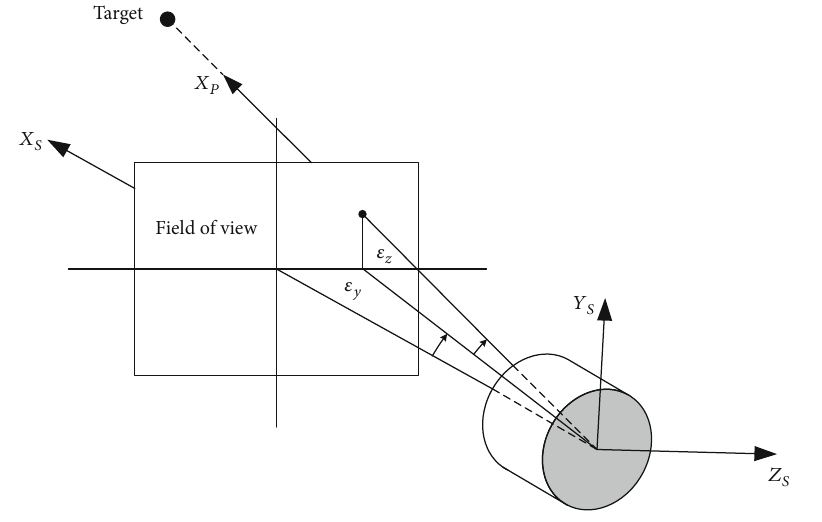
Figure 3: Sensor heading and target pointing frame.